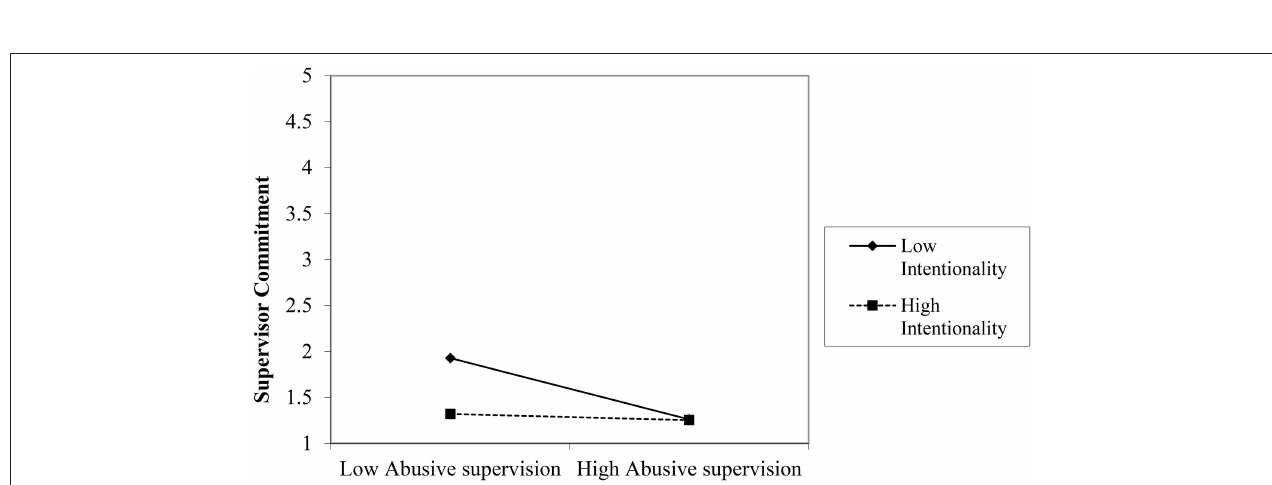
FIGURE 5 | Interaction between abusive supervision and attribution to the supervisor on turnover intention (Study 2).